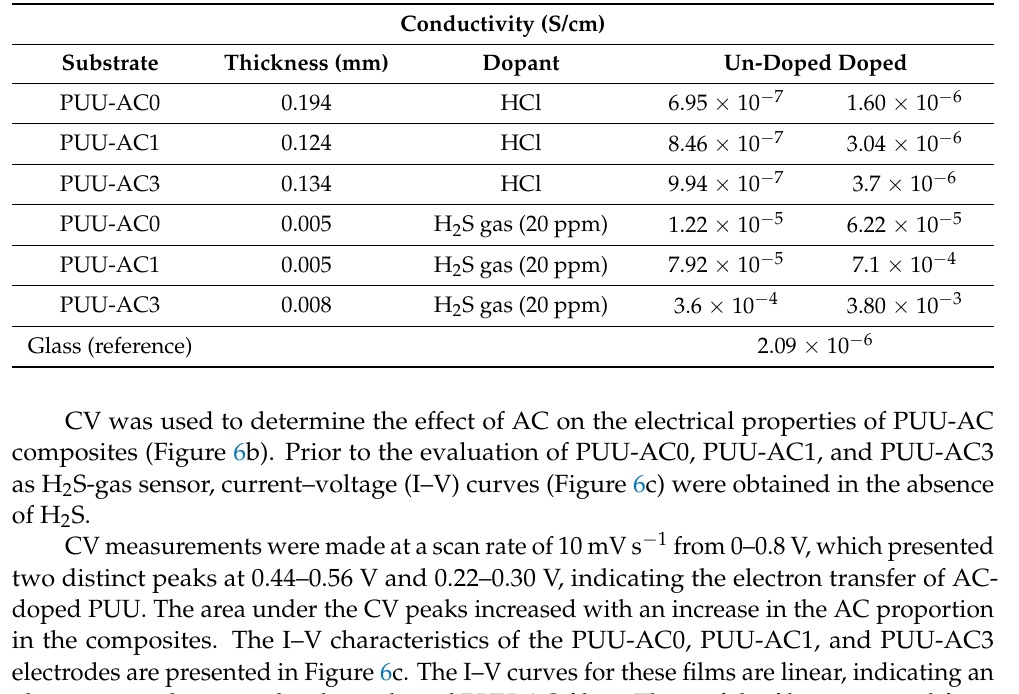
Table 1. Conductivity data of PUU-AC0, PUU-AC1 and PUU-AC3 films, determined via four- point